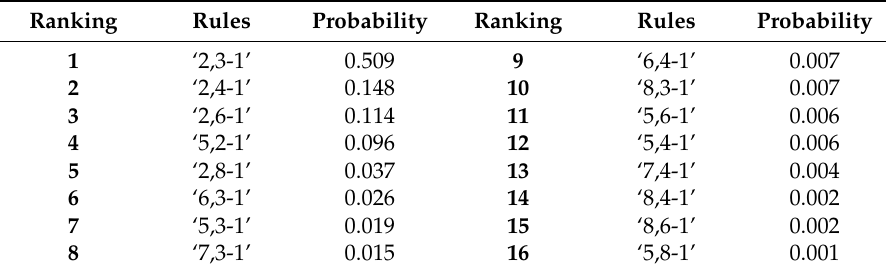
Table 5. Rule ranking with two antecedent and fixed consequents of